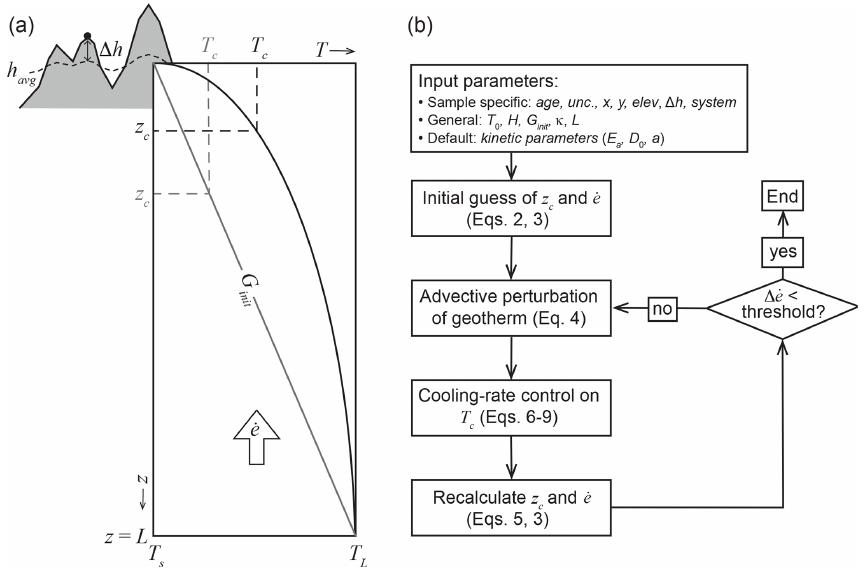
Figure 1. Model outline. (a) Sketch of model showing some of the main model parameters; main plot is a temperature–depth ( T – z ) plot of the model domain, showing initial, unperturbed linear geotherm ( G init ), and initial estimates of closure temperature ( T c ) and closure depth ( z c ) in grey, and final, steady-state advectively perturbed geotherm and calculated T c and z c in black. Note that in most cases, T c will increase because of the increased cooling rate (Eqs. 8 and 9), while z c will decrease due to the advective perturbation of the geotherm (Eq. 5). Inset shows how the local relief correction (cid:49)h is derived from the relationship between sample elevation (indicated by black dot) and average elevation h avg . (b) Flow chart of the model and its main iteration loop. Abbreviations for input parameters are explained in the main text.